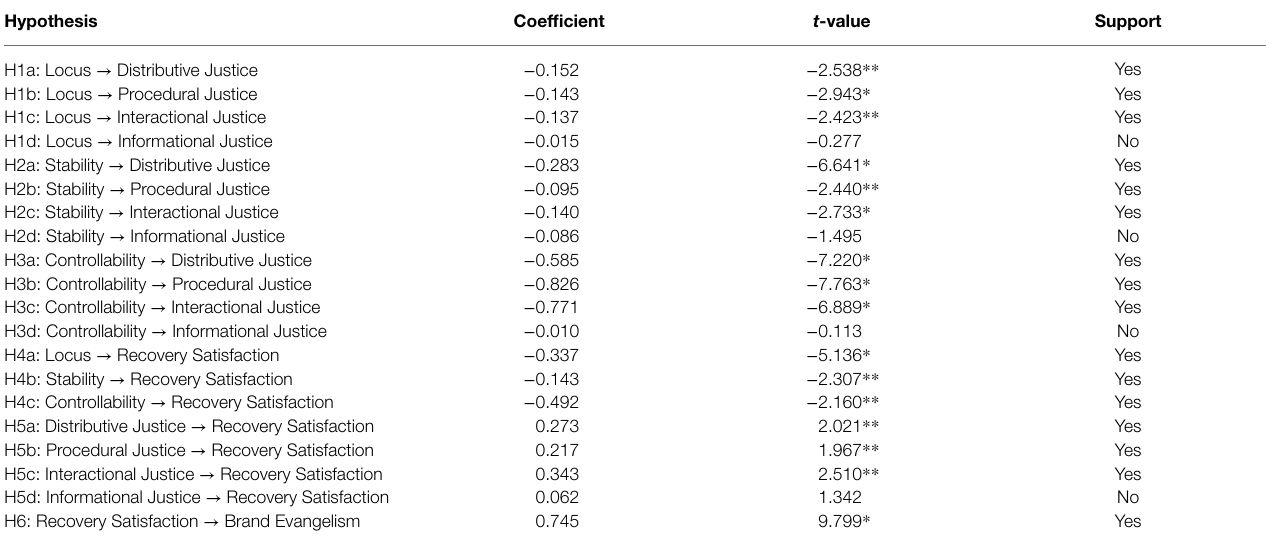
TABLE 4 | Analysis results of hypothesis testing.